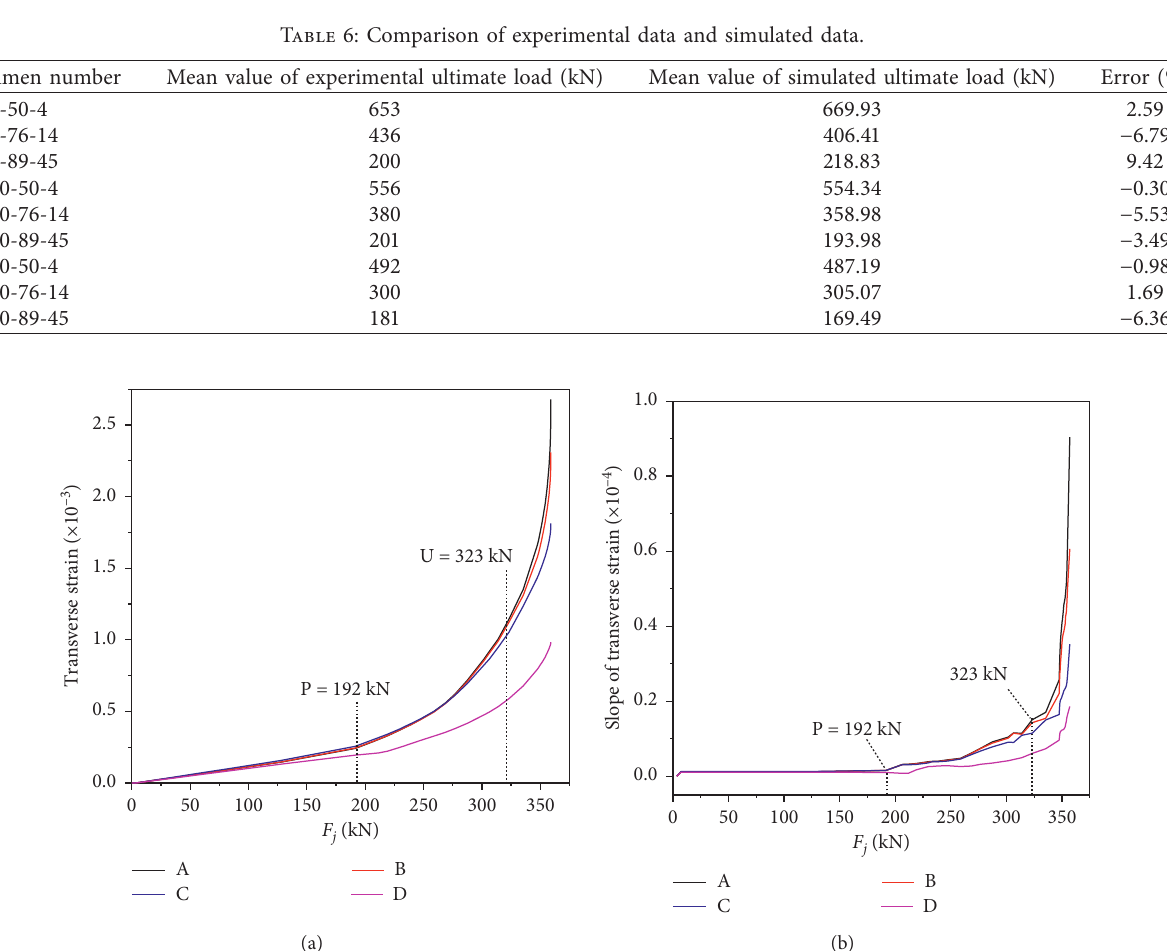
Figure 14: (a) Transverse strain − F